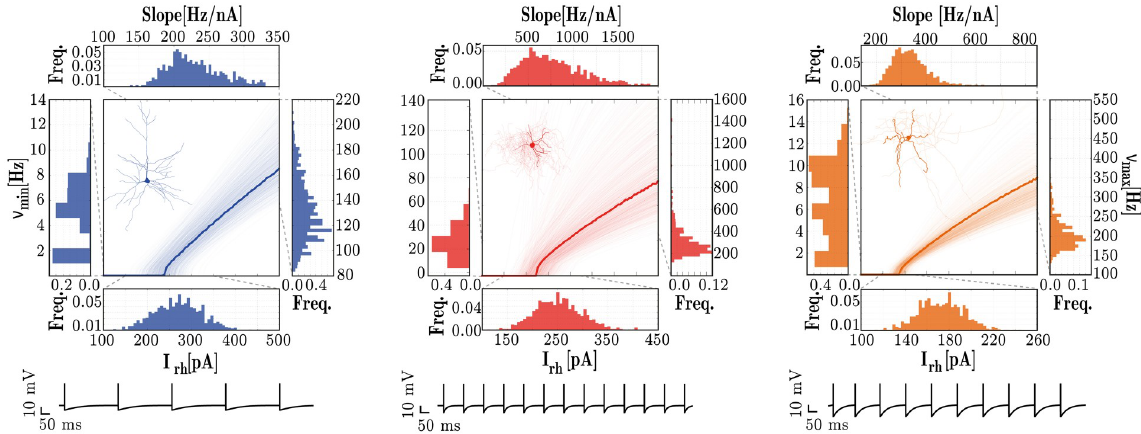
Fig 1. Response properties of the three different neuronal types, E (left), I 1 (middle) and I 2 (right). For each neuronal class, the central panels depict single neuron fI curves and the marginal panels give the corresponding distributions of the neuron’s rheobase currents (I rh [pA], bottom), minimum firing rates ( ν min [ Hz ], left); maximum firing rates ( ν max [ Hz ], right) and the slope of the fI curve (Slope[Hz/nA], top). The data was obtained from 1000 neurons of each class. The membrane potential traces depicted in the bottom correspond to the response of the homogeneous neurons (bold traces in the fI curves) to a stimulus step of amplitude I rh + 10 pA, for a duration of 1 second.